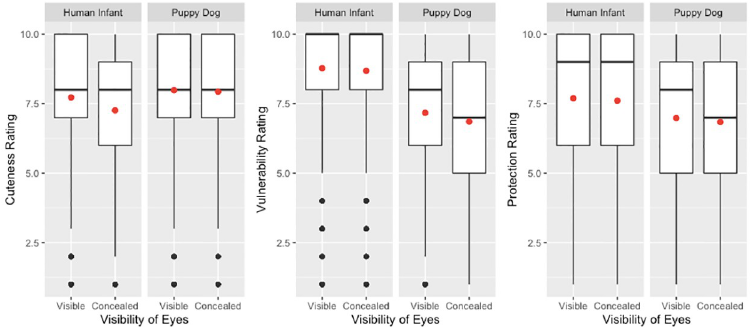
Fig 2. Experiments 1–3: Boxplots depicting ratings of human infants and puppy dogs, as a function of whether their eyes were visible or concealed. The boxplots describe data combined across all three experiments. Boxes indicate interquartile ranges. Bold horizontal lines indicate medians. Red dots indicated means. Black dots indicate outliers.